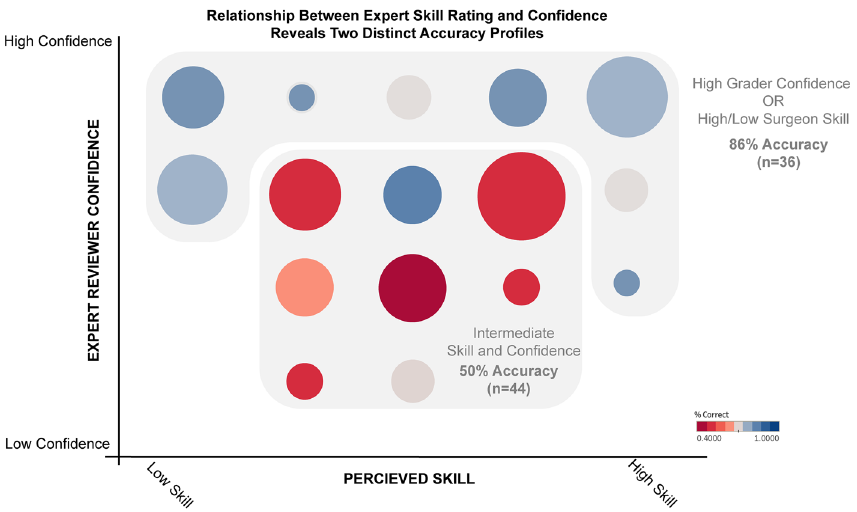
Figure 2. Association between expert confidence, surgeon skill level and accuracy of prediction. Experts are most accurate when viewing trials of surgeons with low or high skill, or where they (experts) are maximally confident. For those with moderate skill or when experts have moderate confidence, prediction accuracy is lower. Size of circle denotes number of trials. Color denotes accuracy.